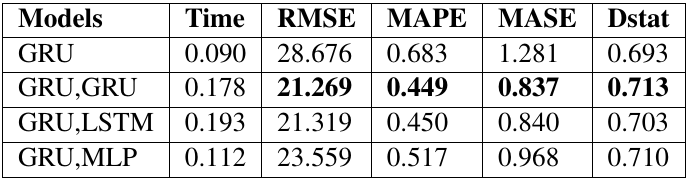
Fig. 9 The high price of test data. Table 2 The experiment results (NN1: GRU, DATA SET: 000001.SH).